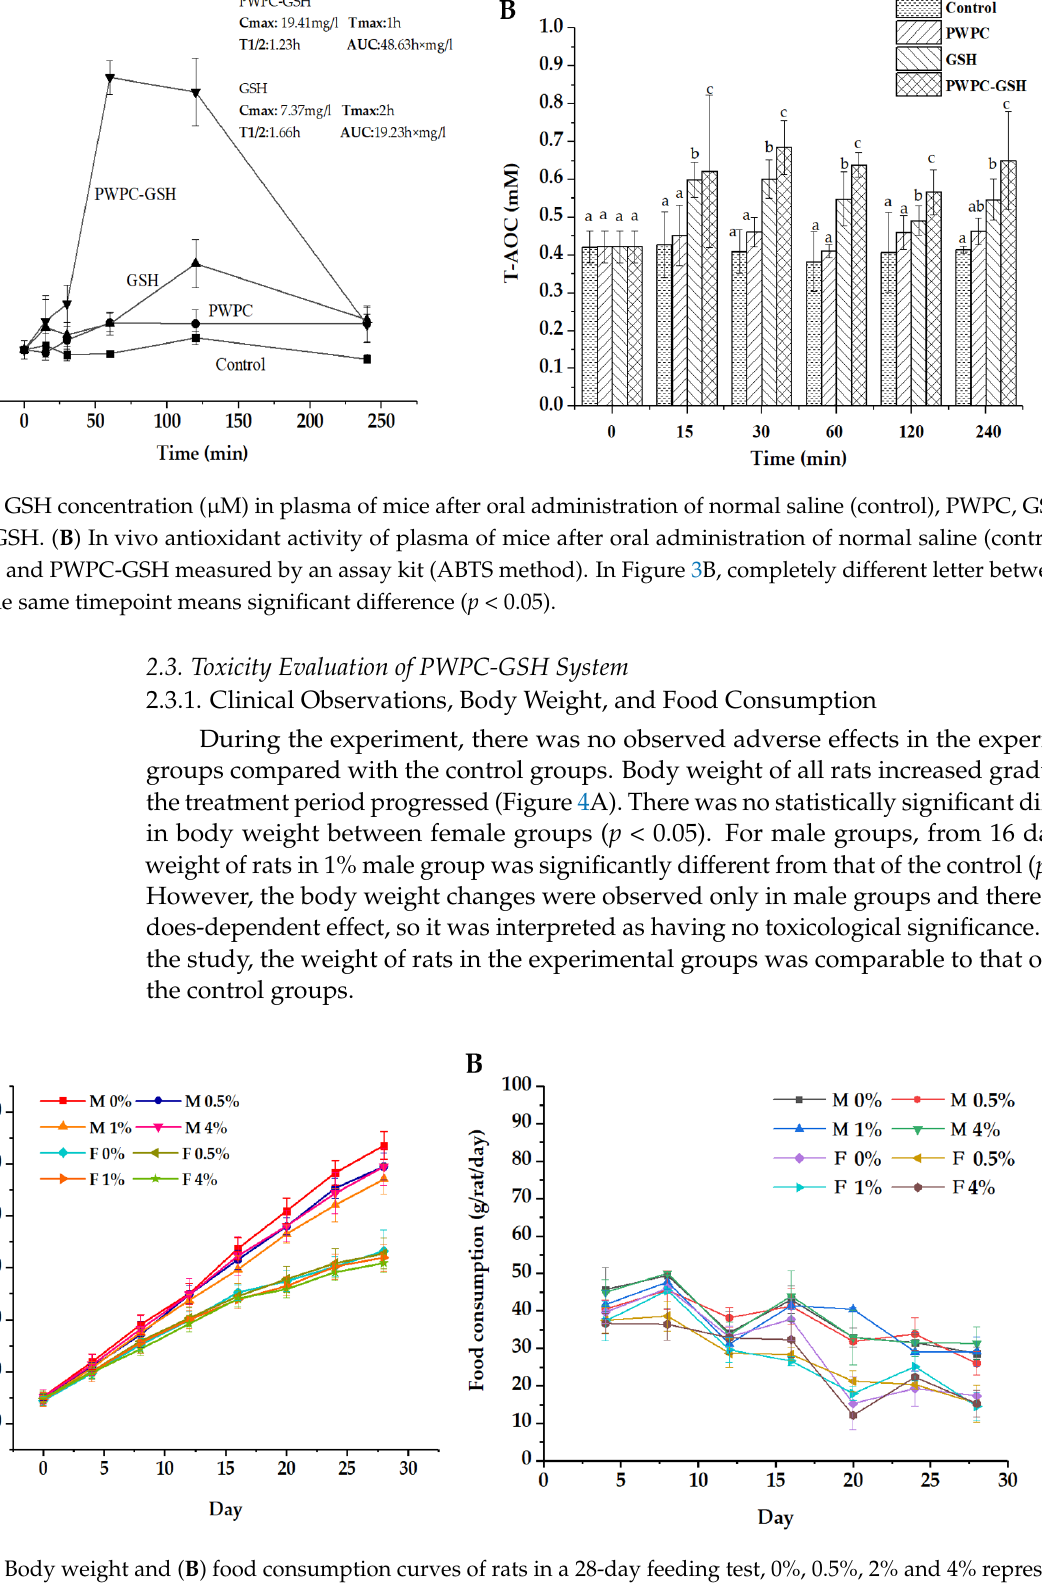
Figure 4. ( A ) Body weight and ( B ) food consumption curves of rats in a 28-day feeding test, 0%, 0.5%, 2% and 4% represent daily intake of 0% ( w / w , control), 0.5% ( w / w , low dose), 1% ( w / w , medium dose) and 4% ( w / w , high dose) of freeze-dried PWPC-GSH powder, respectively.